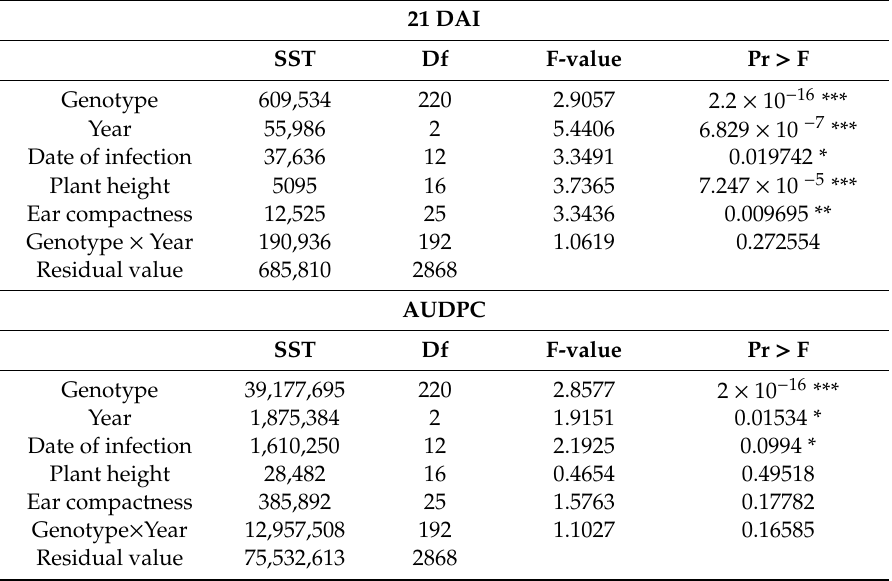
Table 4. The results of the unbalanced ANOVA test, on the basis of the 21 DAI and AUDPC values (21 DAI: infection severity % on the 21st day after inoculation; AUDPC: area under the disease progress curve), under field conditions, based on the years 2006, 2009, and 2011 ( n =